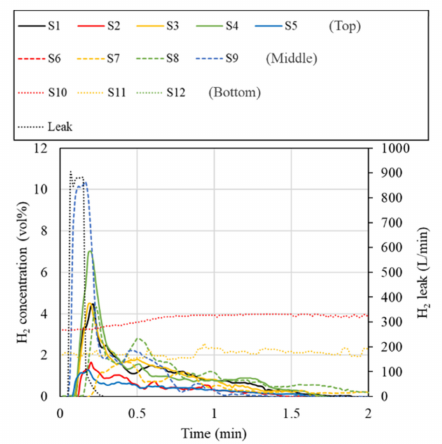
Figure 12. Hydrogen concentration variation by leak (Case 29: hydrogen supply pressure 30 kPa,